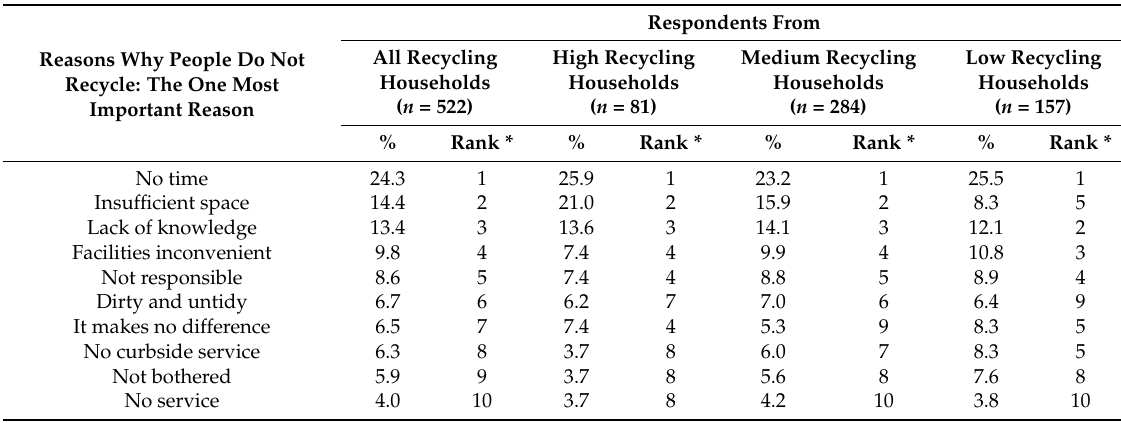
Table 5. Comparing perceptions why people do not recycle across varying recycling levels—order of priority (rank) of the one most important